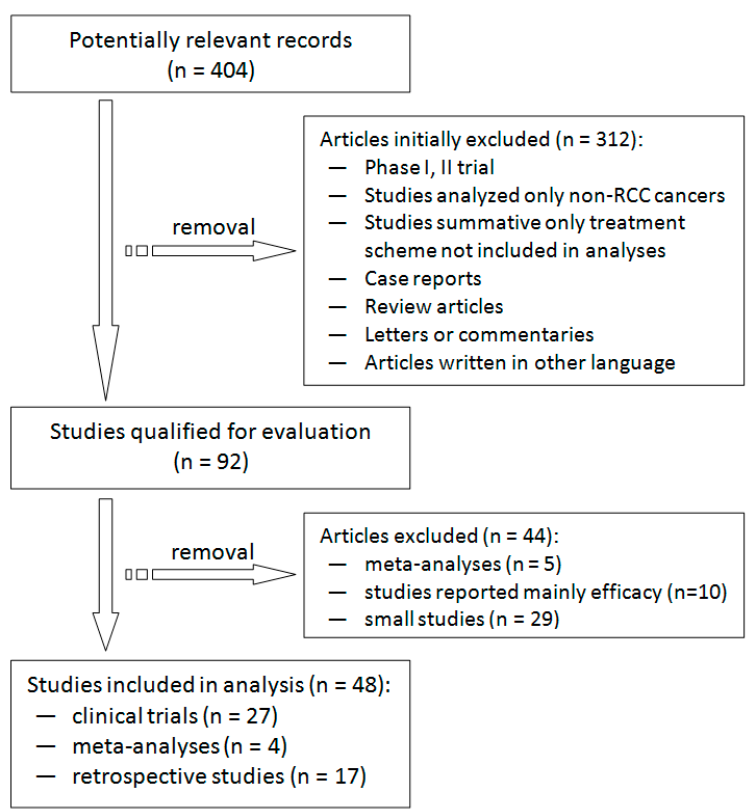
Figure 1. Flow chart of the literature selection process.